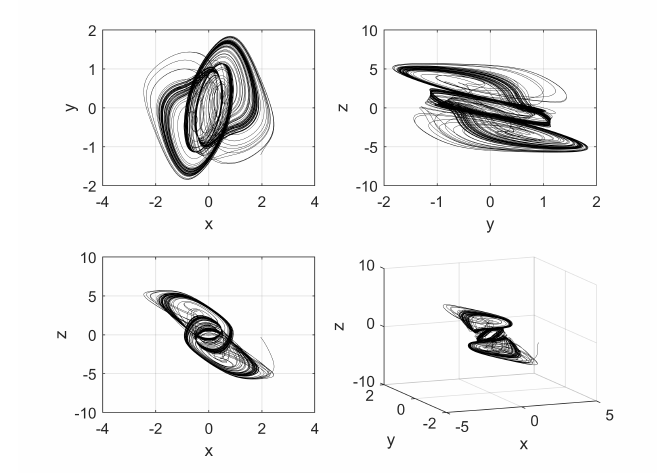
Figure 2. Attractors generated by plotting the state variables shown in Figure